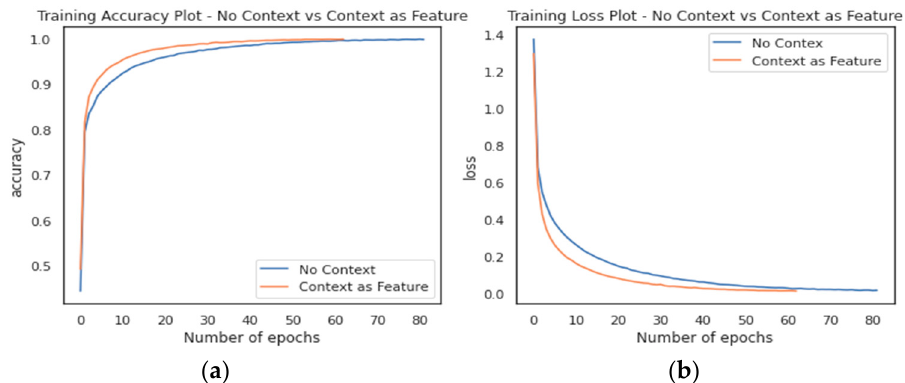
Figure 9. Line plot comparing ( a ) training accuracy and ( b ) training loss between the two models during training.